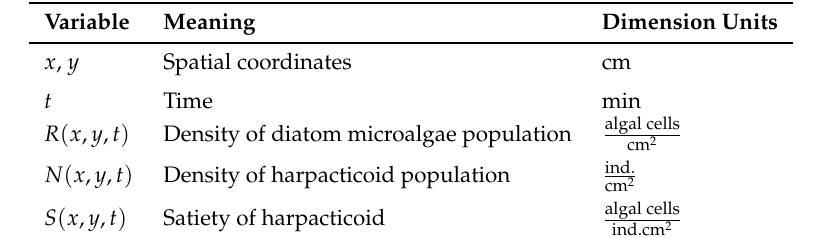
Table 1. Dimension of variables in model (1)–(5).